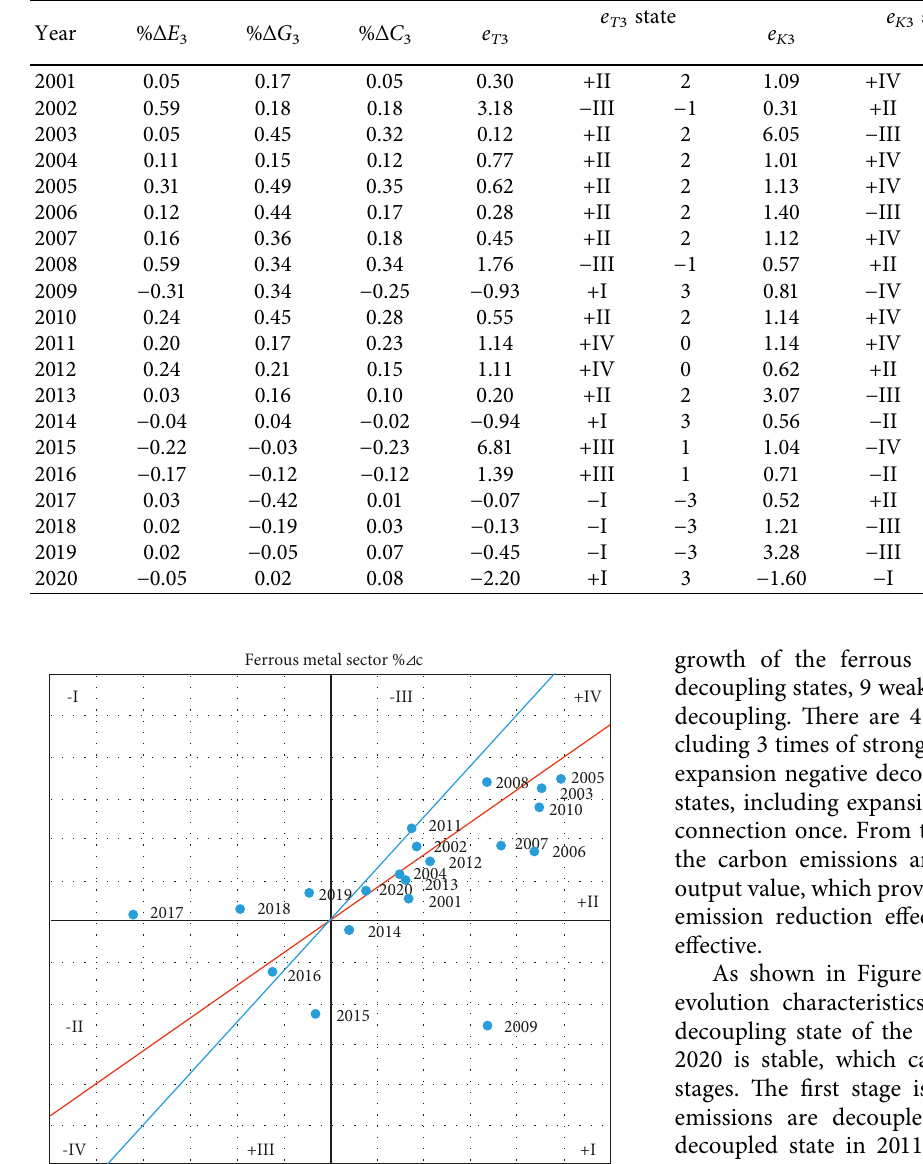
Table 10: Decoupling index and decoupling relationship of the ferrous metal sector from 2001 to 2020.